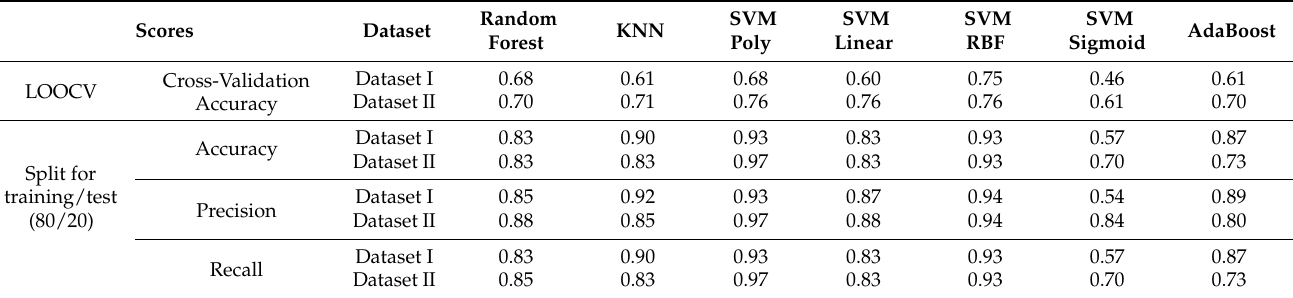
Table 4. Performance of test models with SMOTEN